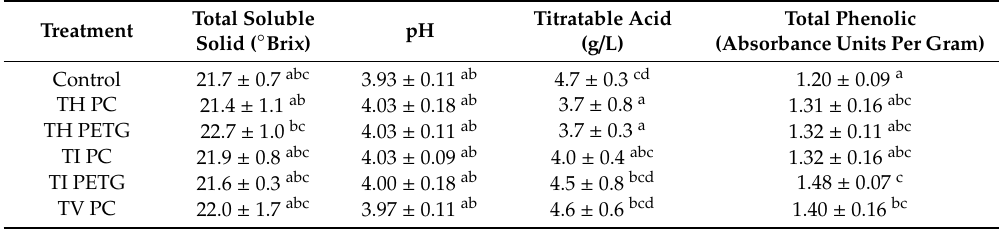
Table 1. Conventional chemical parameters of Shiraz grapes under di ff erent UV attenuation treatments in 2017